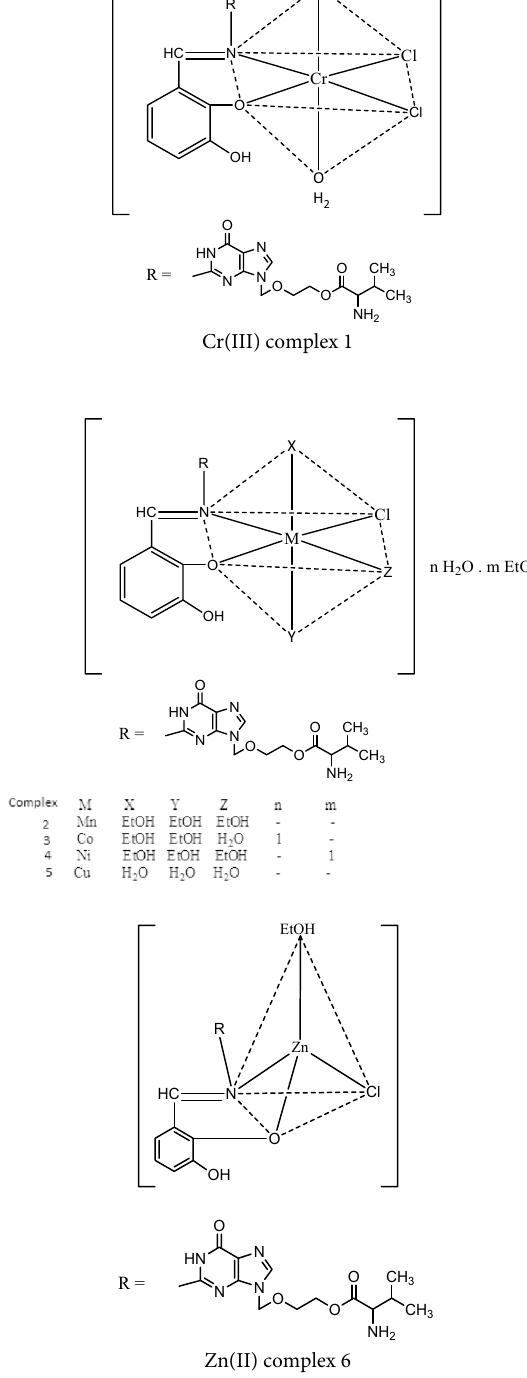
Figure 15. Suggested coordination of the investigated complexes